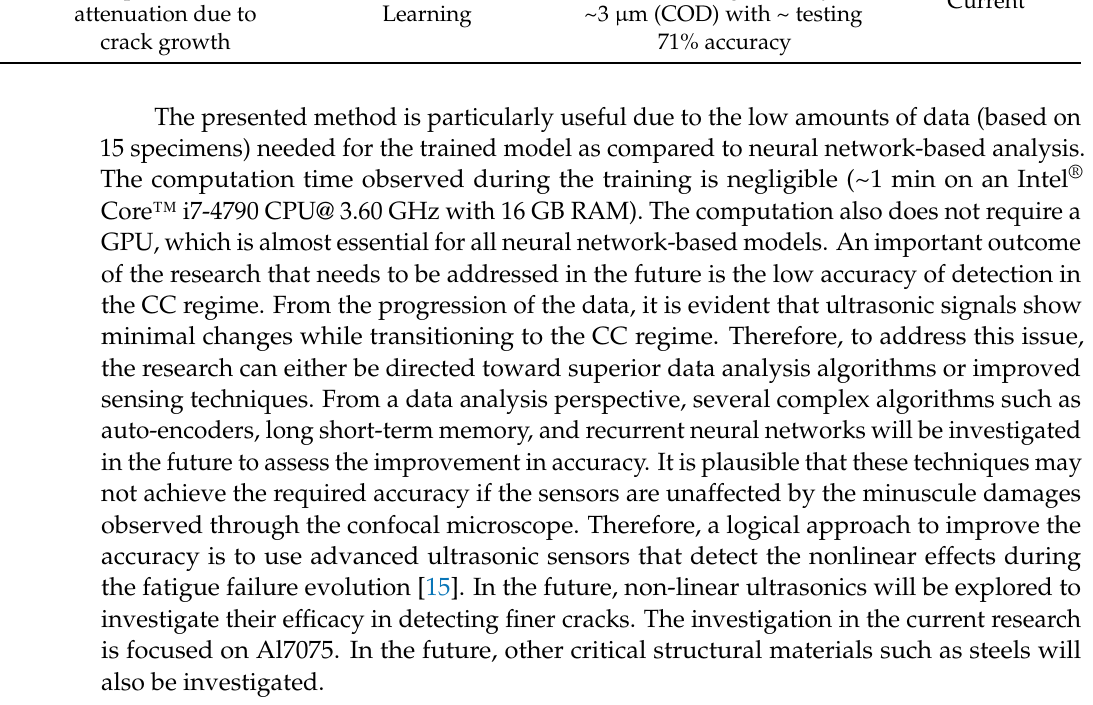
Figure 19. Summary of the training and testing accuracies in the CC and CP regimes for the U- and V-notched specimens.